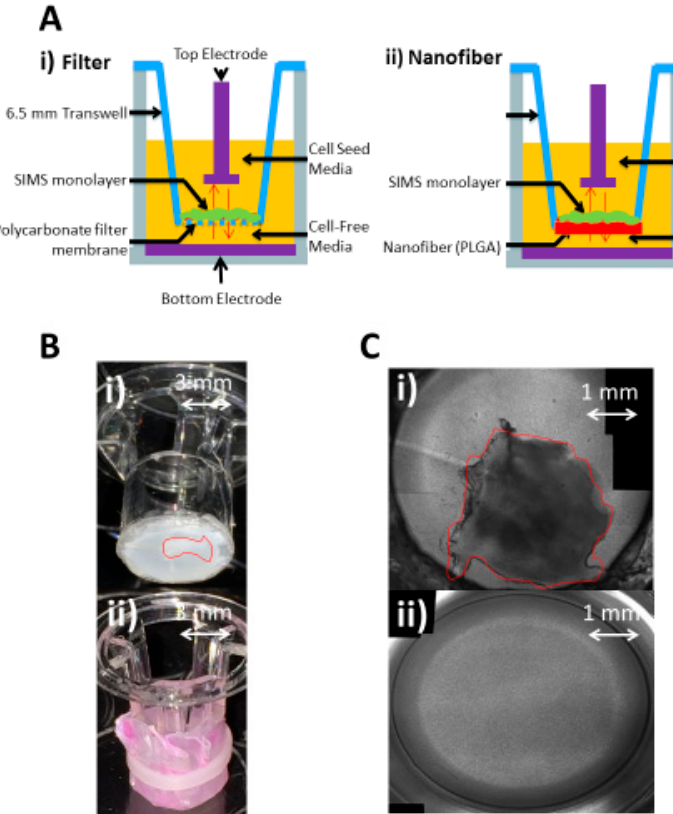
Figure 1. ( A ) Cross-sectional diagrams: (i) Filter-based assembly uses manufactured polycarbonate (PC) filter membrane to support submandibular immortalized mouse salivary (SIMS) epithelial cell monolayer formation, (ii) Nanofiber Transwell, made by excising the filter with a scalpel and securing nanofibers to the base; ( B ) Perspective view of nanofibers added to Transwell inserts by removing the filter membrane with a scalpel: (i) re-attaching with acrylic glue, red outline depicts delaminated nanofibers from the underlying Whatman membrane, (ii) Nanofiber fastening with elastic band; ( C ) 10 × optical image top down: (i) using acrylic glue to secure nanofiber, red outline indicates delaminated nanofibers, (ii) using elastic band, fiber integrity is maintained. Band tension provides the ideal combination of force and slippage to support fiber hydration and cell culture.